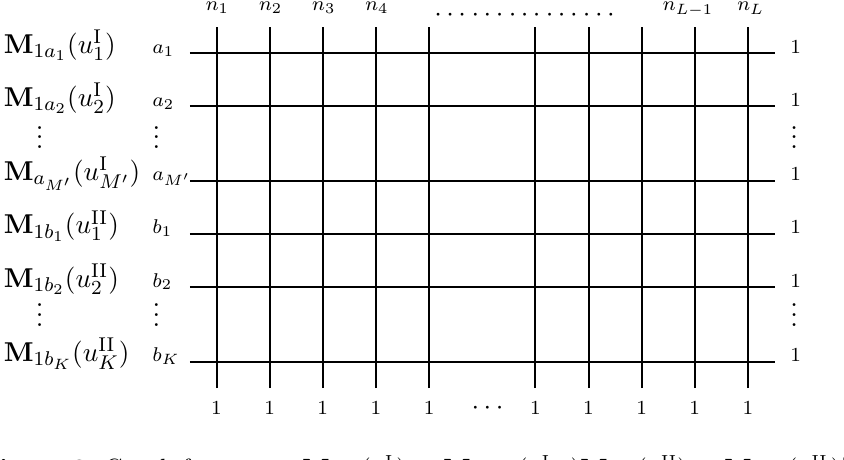
Figure 3 . Graph for a state M 1 a The vertices in other parts of the lattice are “frozen” in the sense that the states (colors) are all fixed. While the right part of the box contains only black lines, the left part contains horizontal color lines, such that only vertical black lines are allowed.